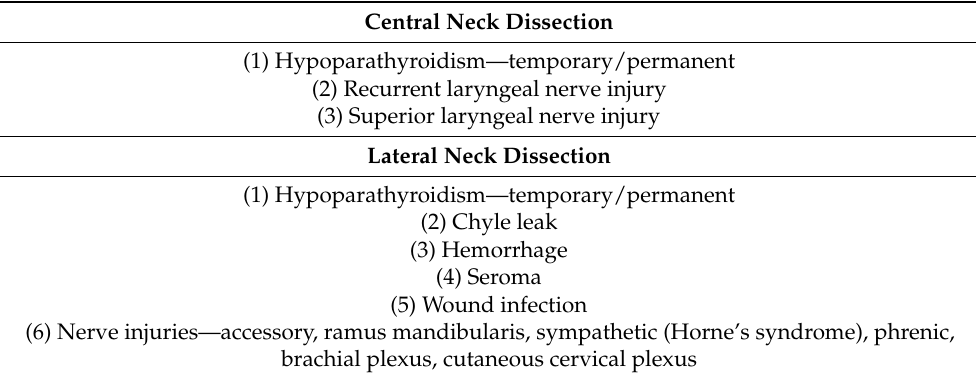
Table 1. Complications of neck dissection for thyroid